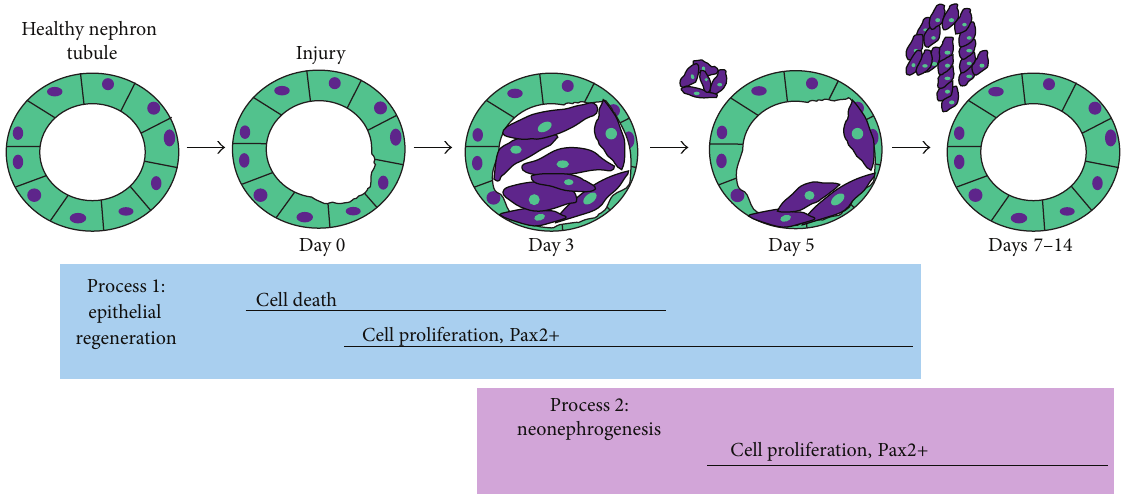
Figure 9: Summary of major cellular events in zebrafish kidney regeneration. After injury to proximal tubules of nephrons within the adult zebrafish kidney, successive and overlapping waves of cell death and cell proliferation occur. Cell proliferation is accompanied by Pax2 expression. Neonephrogenesis entails abundant Pax2 expression and cell proliferation in neonephron structures during the regeneration